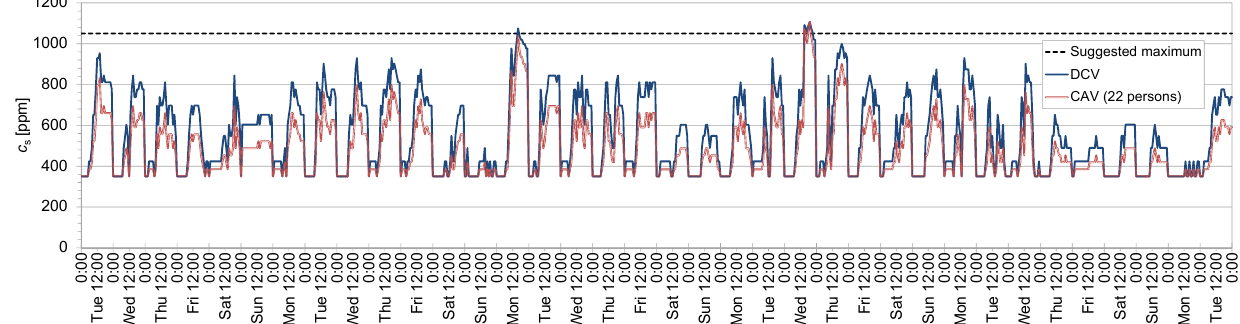
Figure 7. Modeled hourly steady state CO visitor counting sensor based DCV and CAV. The suggested maximum CO corresponds to a space occupied by sedentary